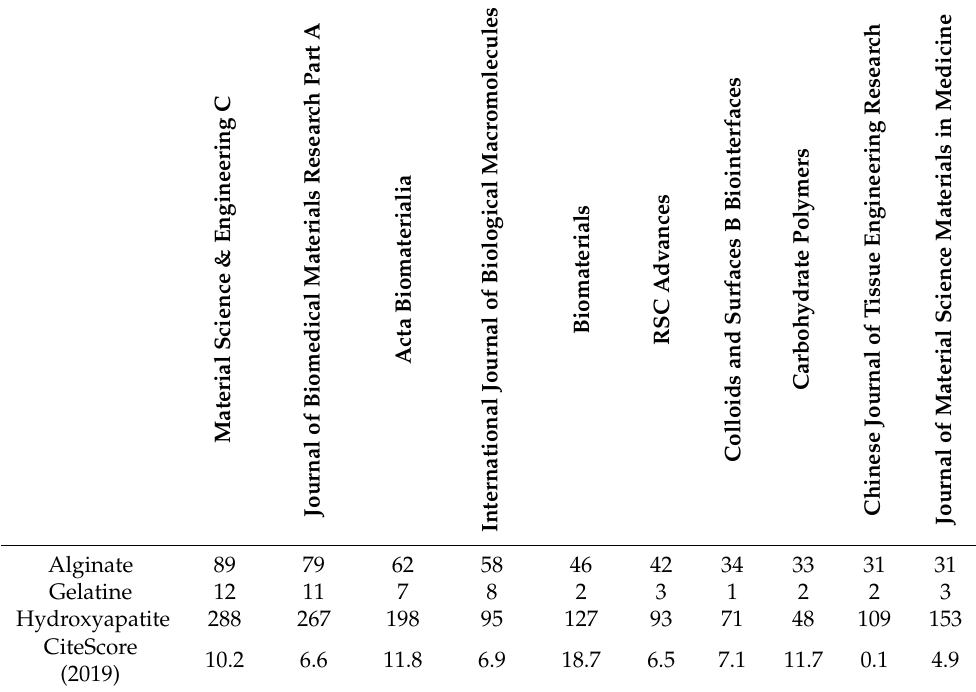
Figure 5. ( a ) Author keywords map for alginate (2009–2019); ( b ) Author keywords map for gelatine (2009–2019); ( c ) Author keywords map for hydroxyapatite (2009–2019). Table 6. Top ten publishing journals